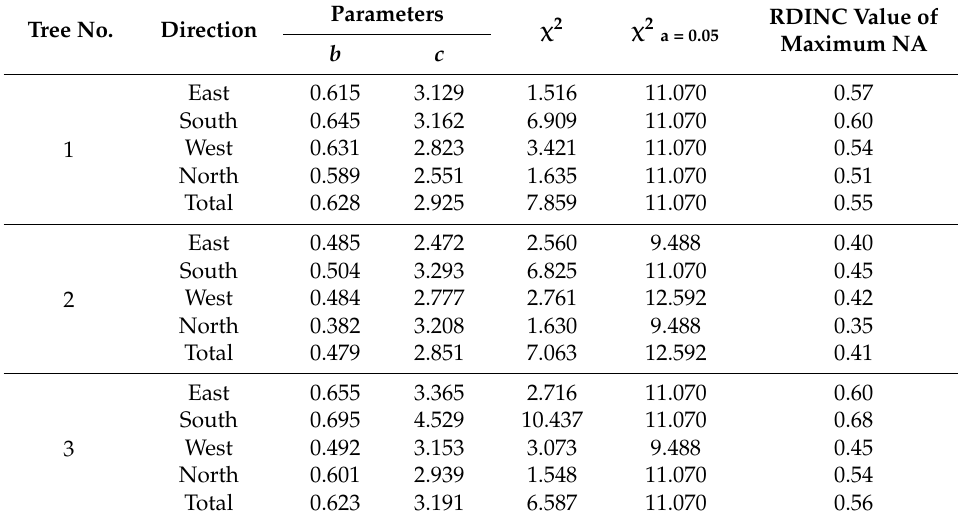
Table 2. Parameter estimates and Chi-square test of the Weibull function fitted to the vertical distribution of NA in different